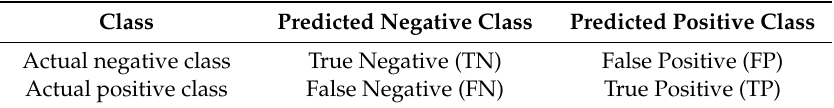
Table 4. Confusion